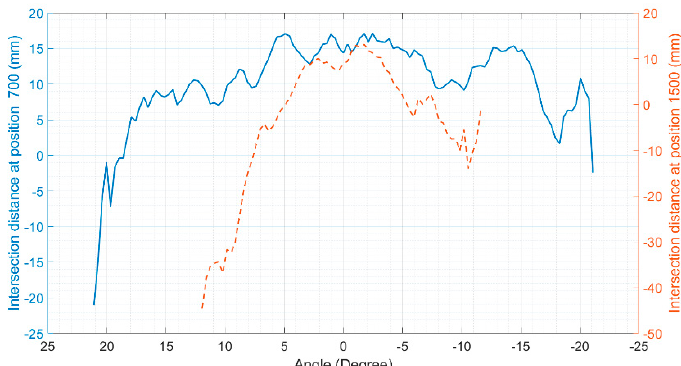
Figure 9. Difference error between real and synthetic data (measurement model only). The continuous line represents errors at 700 mm of the sensor’s central ray. The dashed line represents errors at 1500 mm of the sensor’s central ray. Sensors 2020 , 20 , x FOR PEER REVIEW